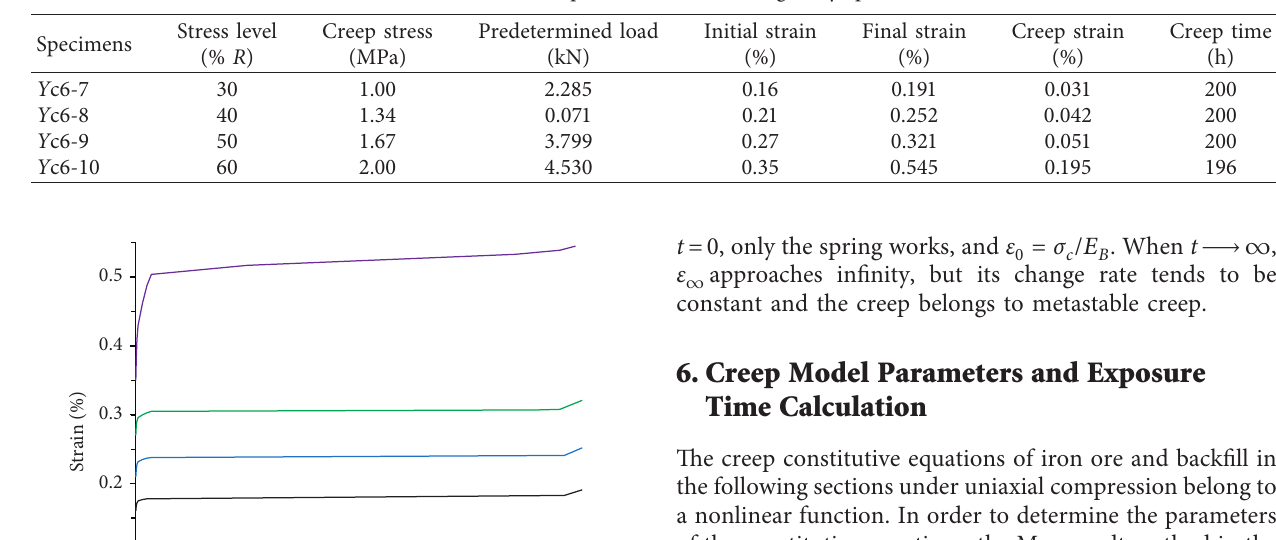
Figure 5: Creep experiment of the filling Table 3: Uniaxial creep statistics of the filling body specimens.